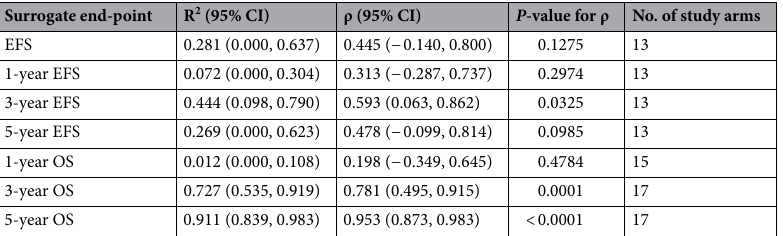
Surrogate end-point R 2 (95% CI) ρ (95%